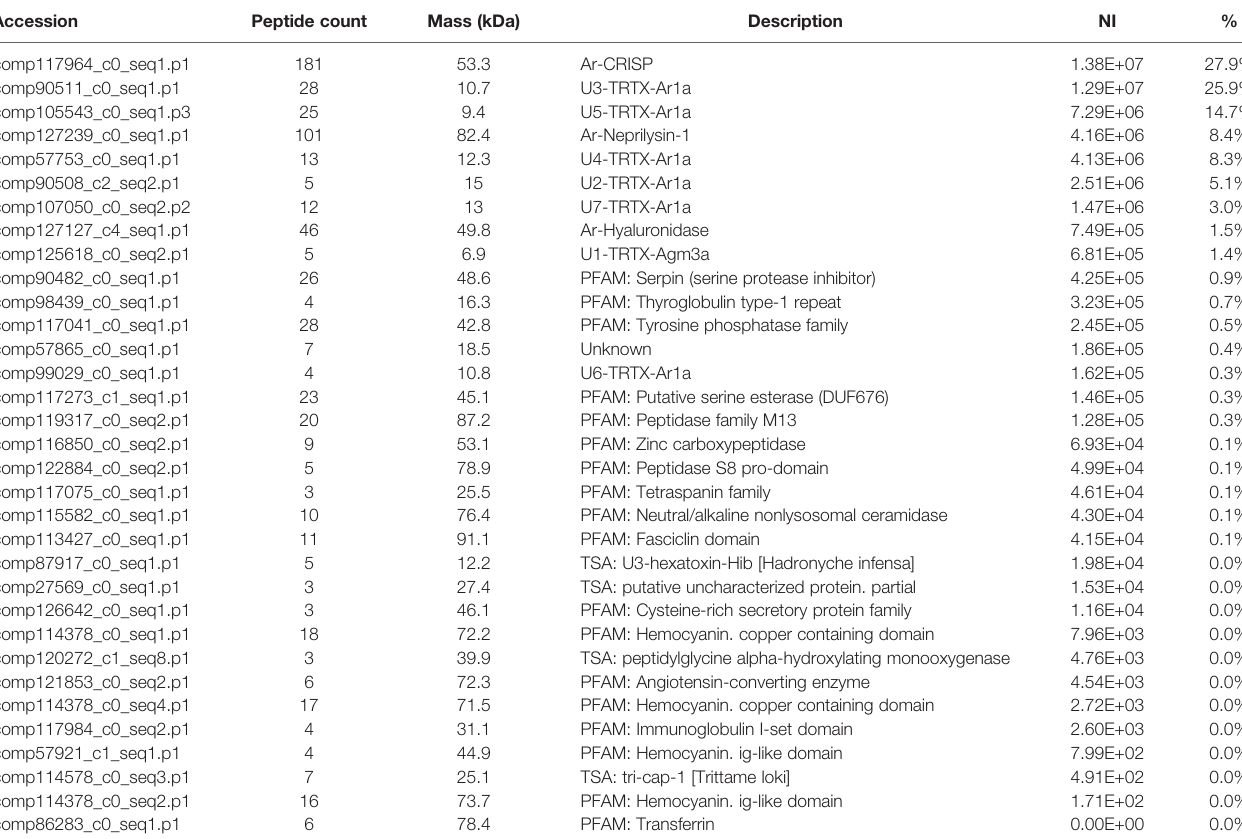
TABLE 2 | Relative quanti fi cation of proteins by proteomic analysis of the venom of Acanthoscurria rondoniae . Accession Peptide count Mass (kDa)